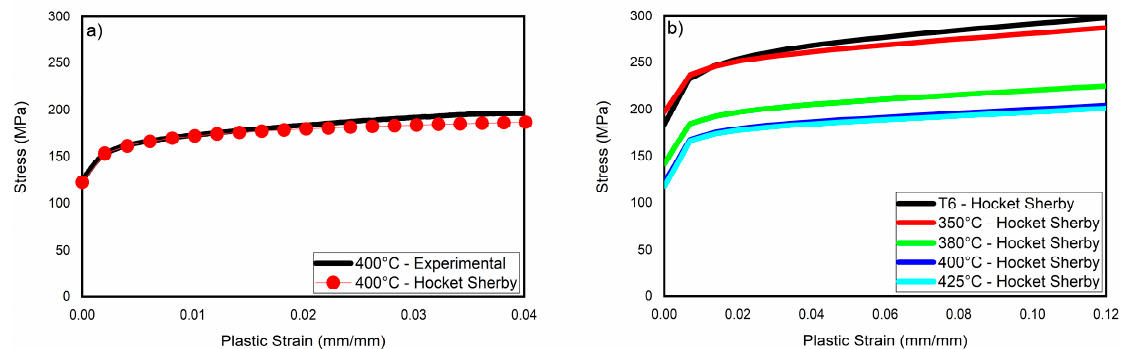
Figure 8. Stress–strain curves. ( a ) A comparison of the experimental and the generated curve by the Hocket–Sherby model and ( b ) the generated Hocket–Sherby curves at different conditions.